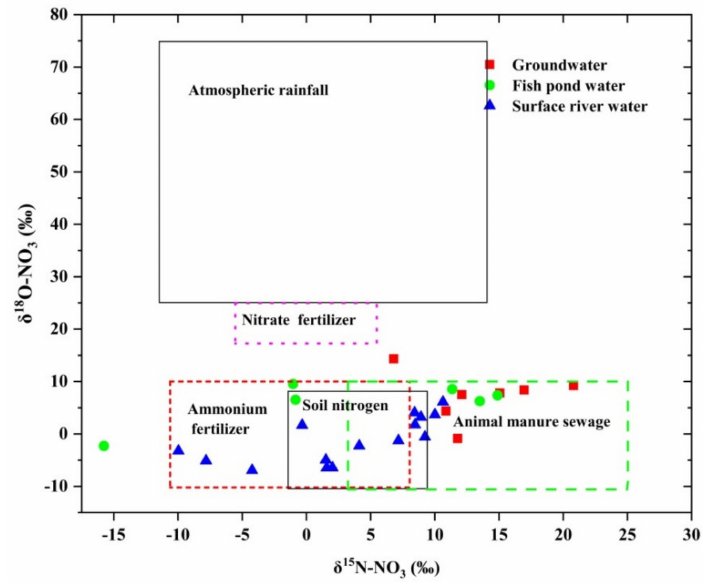
Figure 7. The relationship between δ 15 N-NO 3 and δ 18 O-NO 3 in three kinds of water